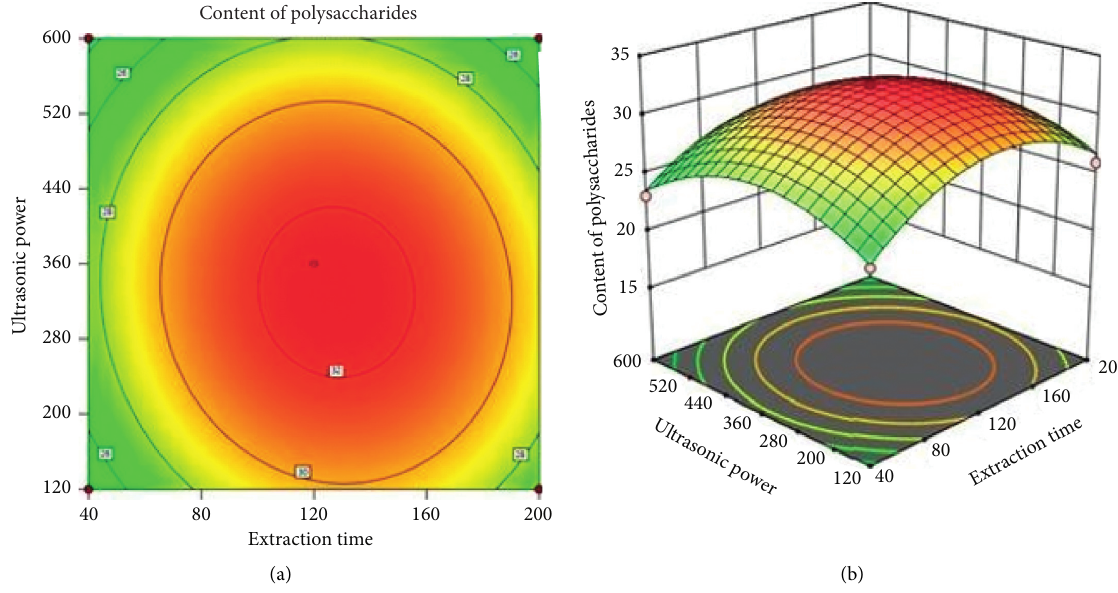
Figure 7: Simultaneous effect of extraction time and ultrasonic power on the content of polysaccharides. Table 4: Predicted and experimental optimum extraction